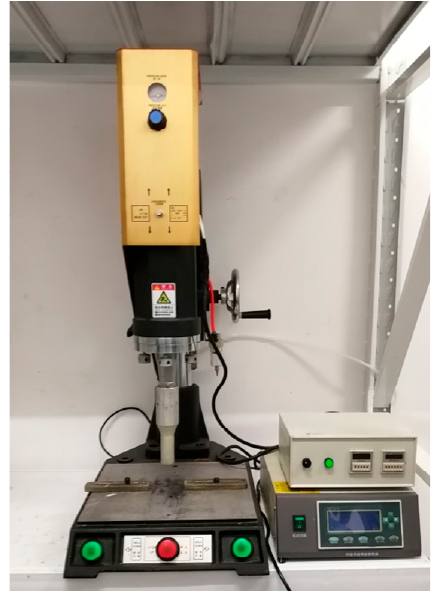
Figure 6. Ultrasonic experiment platform.